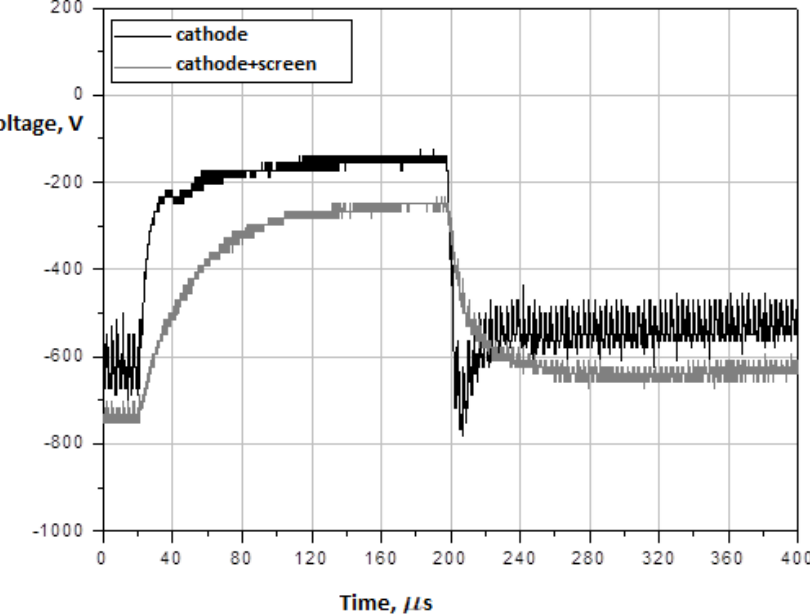
Figure 12. Comparison of the voltage waveforms on the screened sample (bottom) and the un- screened sample (top). Recorded with a time base of 40 µ